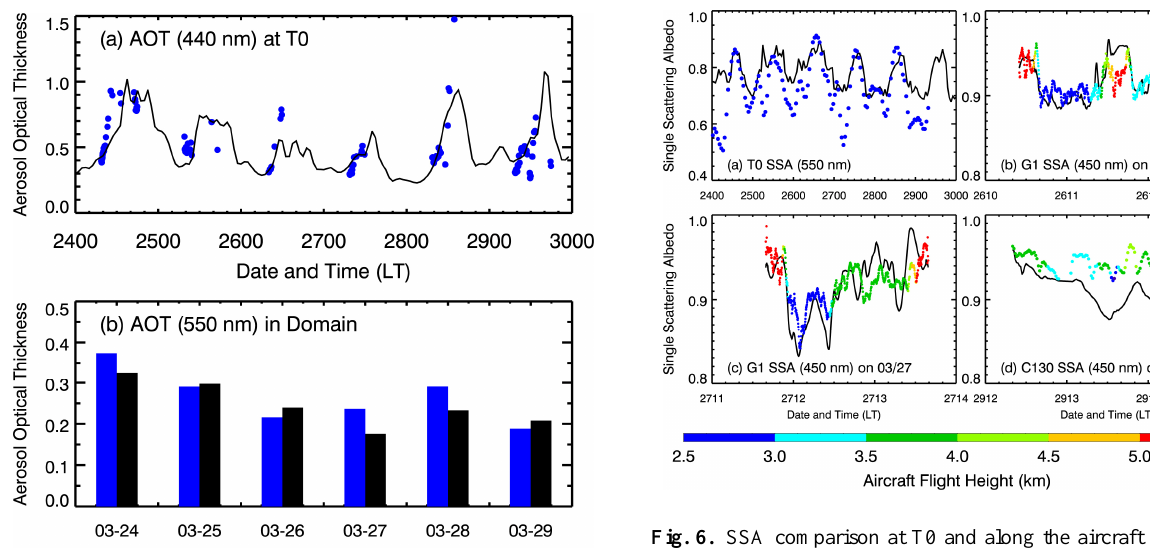
Fig. 6. SSA comparison at T0 and along the aircraft tracks. For (a) , the black line represents model simulations and blue dots are measurements at T0. For (b) , (c) , and (d) , dots with different colors are aircraft measurements and the black line represents the model results. See Fig. 2 for the x-axis